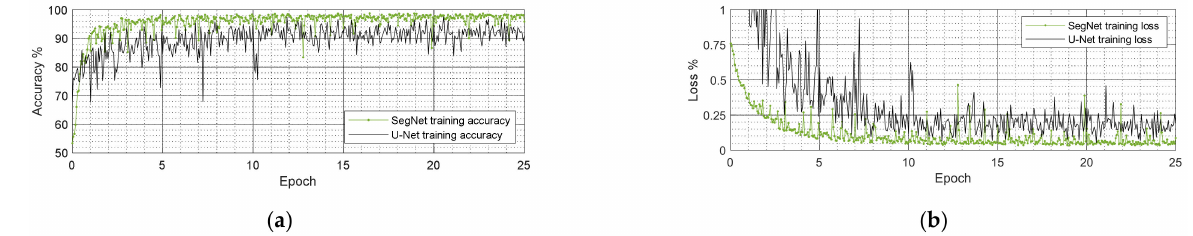
Figure 9. ( a ) Accuracy and ( b ) loss training curves for both studied CNNs.